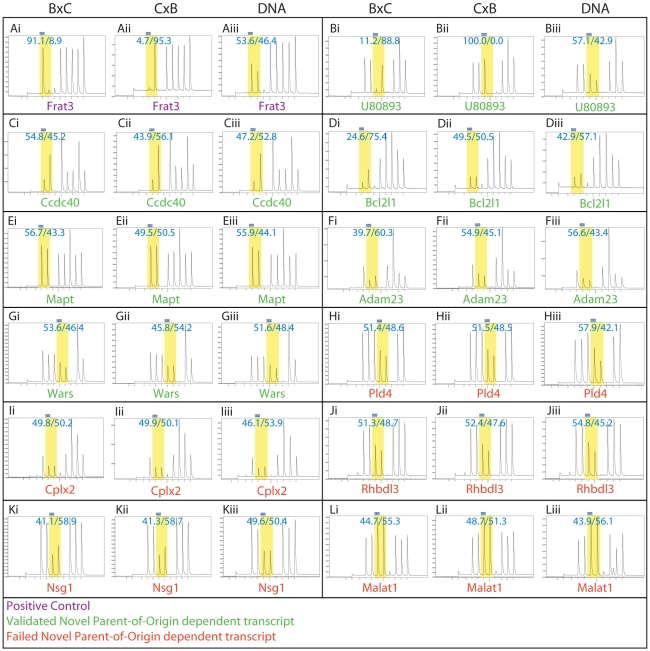
Pyrosequencing traces confirmed 6 of the 11 predicted novel parent-of-origin effects in E17.5 brains.For each gene (A–L), (i) are traces from E17.5 brains from BxC parents, (ii) are traces of E17.5 brains from CxB parents and (iii) are traces on genomic DNA from BxC parents. (A) Frat3 is a positive control. (B–G) Confirmed novel parent-of-origin effects. The Bcl2l1 traces illustrate the utility of sequencing 50∶50 hybrid BxC DNA to calibrate each assay. In this particular assay an unknown effect caused a slight allelic bias (57∶43) even in the case where input was 50∶50 B∶C DNA. If assay bias is not accounted for, the Bcl2l1 reciprocal F1 traces suggest a genetic background effect on allelic bias, but support a parent-of-origin effect once assay bias is accounted for by normalization to the 50∶50 hybrid DNA. Please see Materials and Methods for details on estimating significance of bias from technical replicate runs. (H–L) Predicted novel parent-of-origin effects that did not validate. In all cases, SNPs are highlighted in yellow with the percent contribution of each nucleotide superimposed on each. Note that the sequencing chemistry is such that adenosine produces 16% more signal than other nucleotides in the trace (Qiagen, personal communication) and the Pyromark software accounts for this when calculating the allelic ratio.